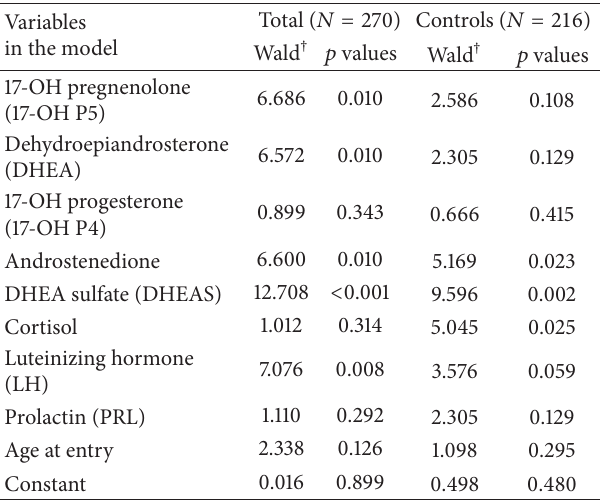
Table 4: Logistic regression model of sex outcome including steroidal and hormonal variables, but not testosterone and estradiol levels ∗